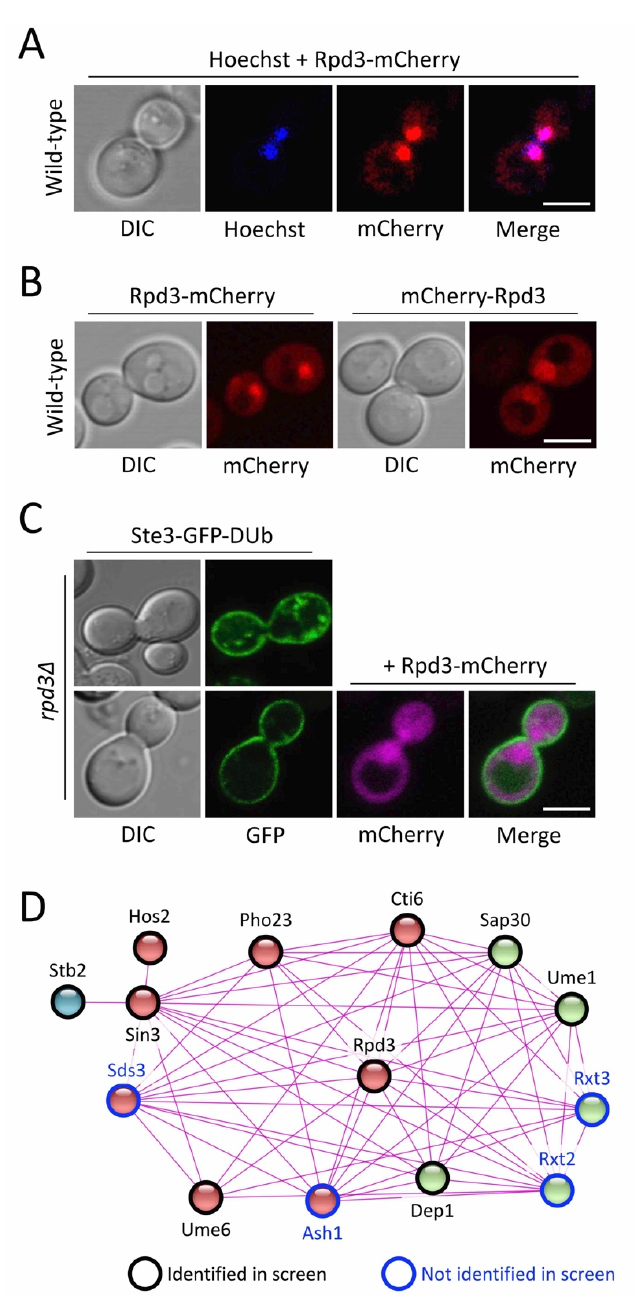
Figure 4. Rpd3 complex members regulate Ste3-GFP-DUb recycling. ( A ) Wild-type cells expressing Rpd3-mCherry were grown to mid-log phase, washed twice in fresh media and then incubated for 30 min with water containing 8 µM Hoechst, followed by fluorescence microscopy. ( B ) Yeast cells transformed with plasmids expressing Rpd3 from the CUP1 promoter with either a C-terminal ( left ) or N-terminal ( right ) mCherry tag were grown to mid-log phase in media containing 50 µM copper chloride prior to confocal microscopy. ( C ) Mutant rpd3 ∆ cells expressing an endogenously expressed version of Ste3-GFP-DUb were transformed with a vector control (upper) and a plasmid encoding Rpd3-mCherry under control of the CUP1 promoter (lower). Transformants were grown to mid-log phase prior to confocal microscopy. ( D ) A protein association network based only on experimental evidence of physical interactions (confidence = 0.400) was generated for the Large Rpd3 complex using STRING v11.5. Entries are coloured based on a k-means clustering algorithm for 3 clusters (red, green, blue) but also outlines indicate whether mutants of these proteins were identified (black) or not (blue) from the Ste3-GFP-DUb localisation screen. Scale bar, 5 µm.